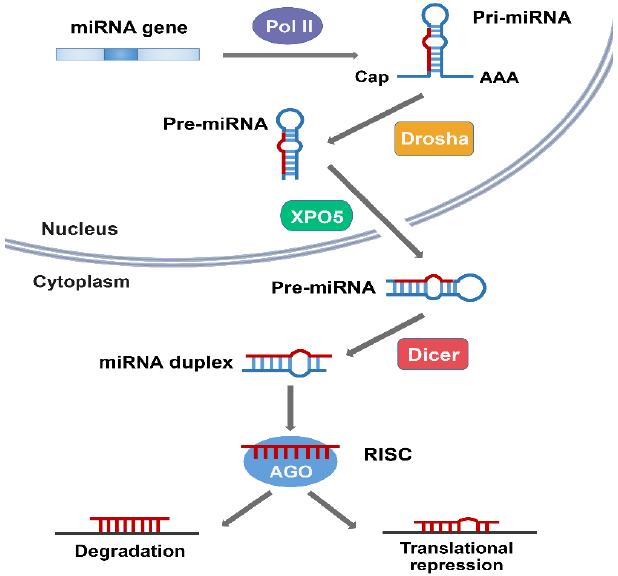
Figure 1. The biogenesis of microRNA (miRNA). MiRNA is transcribed by RNA polymerase II (pol II) in the nucleus as a pre-miRNA, processed by Drosha to a pre-miRNA. Pre-miRNA is then exported from the nucleus to the cytoplasm by exportin 5 (XPO5). In the cytoplasm, Dicer cleaves pre-miRNA to produce the miRNA duplex, and one strand of the resulting duplex is loaded onto the Argonaute (AGO) protein to form a miRNA-induced silencing complex (miRISC), which targets mRNAs for regulation. MiRNAs that form perfect duplexes with their targets direct degradation and those that support partial duplexes inhibit protein expression.